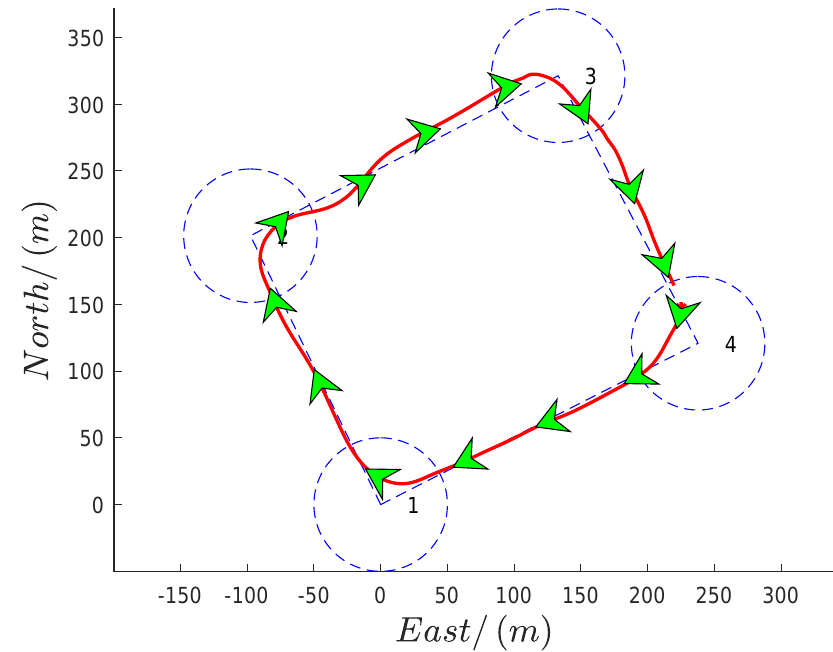
Figure 16. The trajectory curve of the drone when tracking four-sided paths.